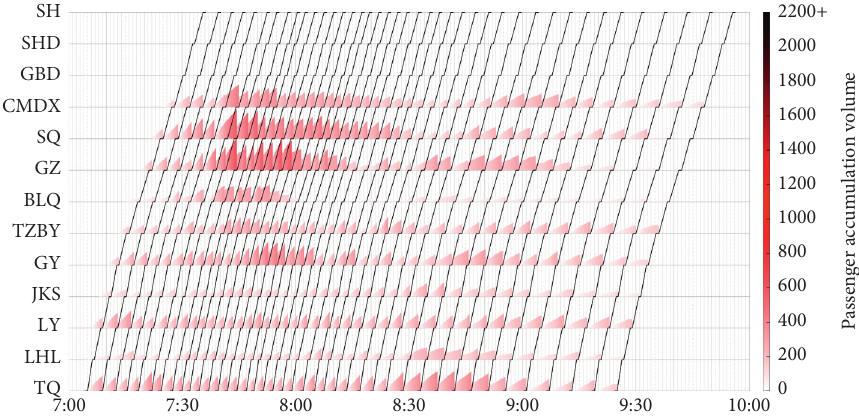
Figure 9: The timetable and passenger accumulation for